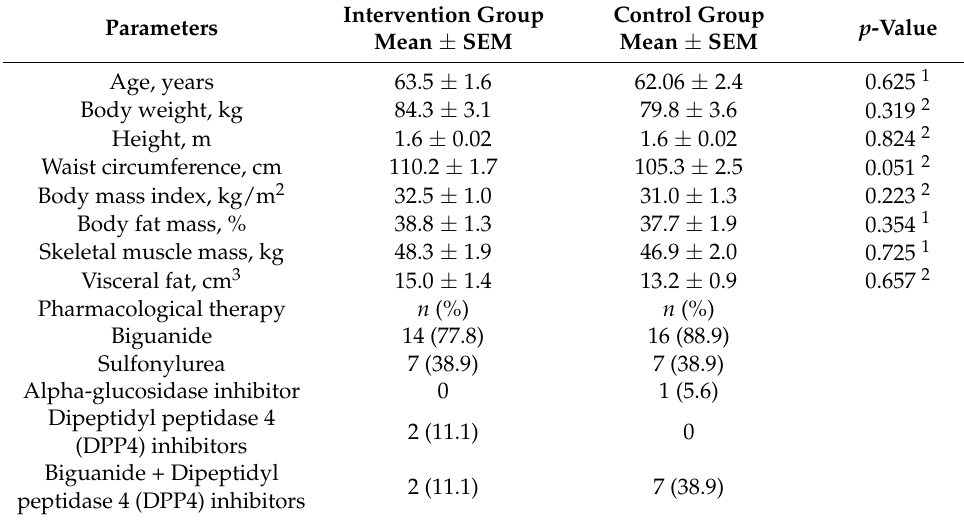
Table 1. Baseline characteristics of the participants for intervention ( n = 18) and control ( n = 18)